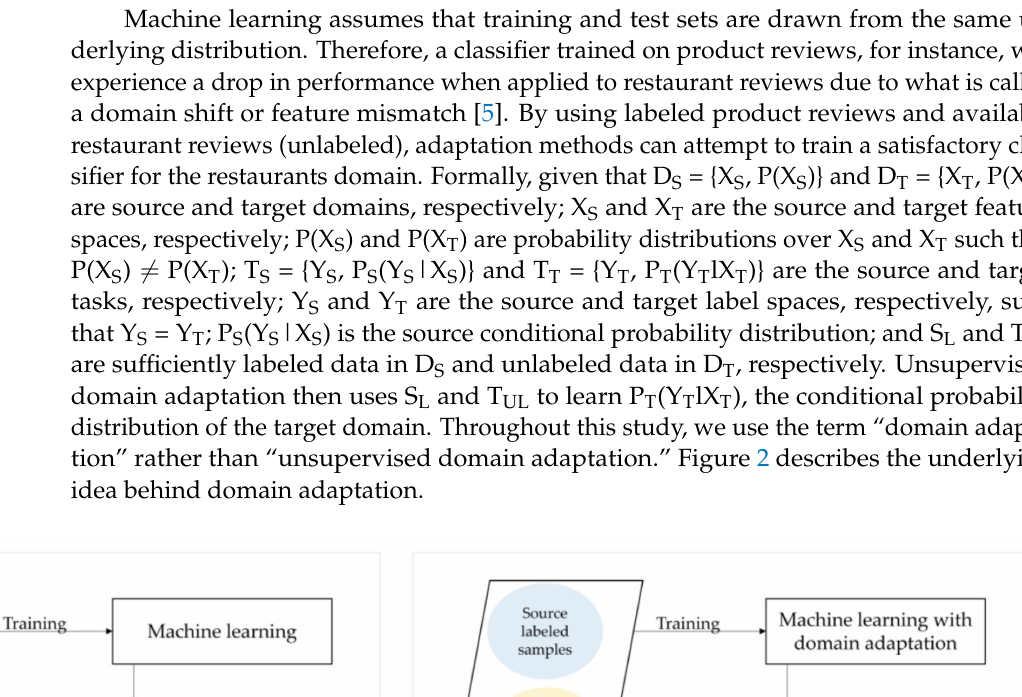
Figure 1. Examples of different words from two different domains.